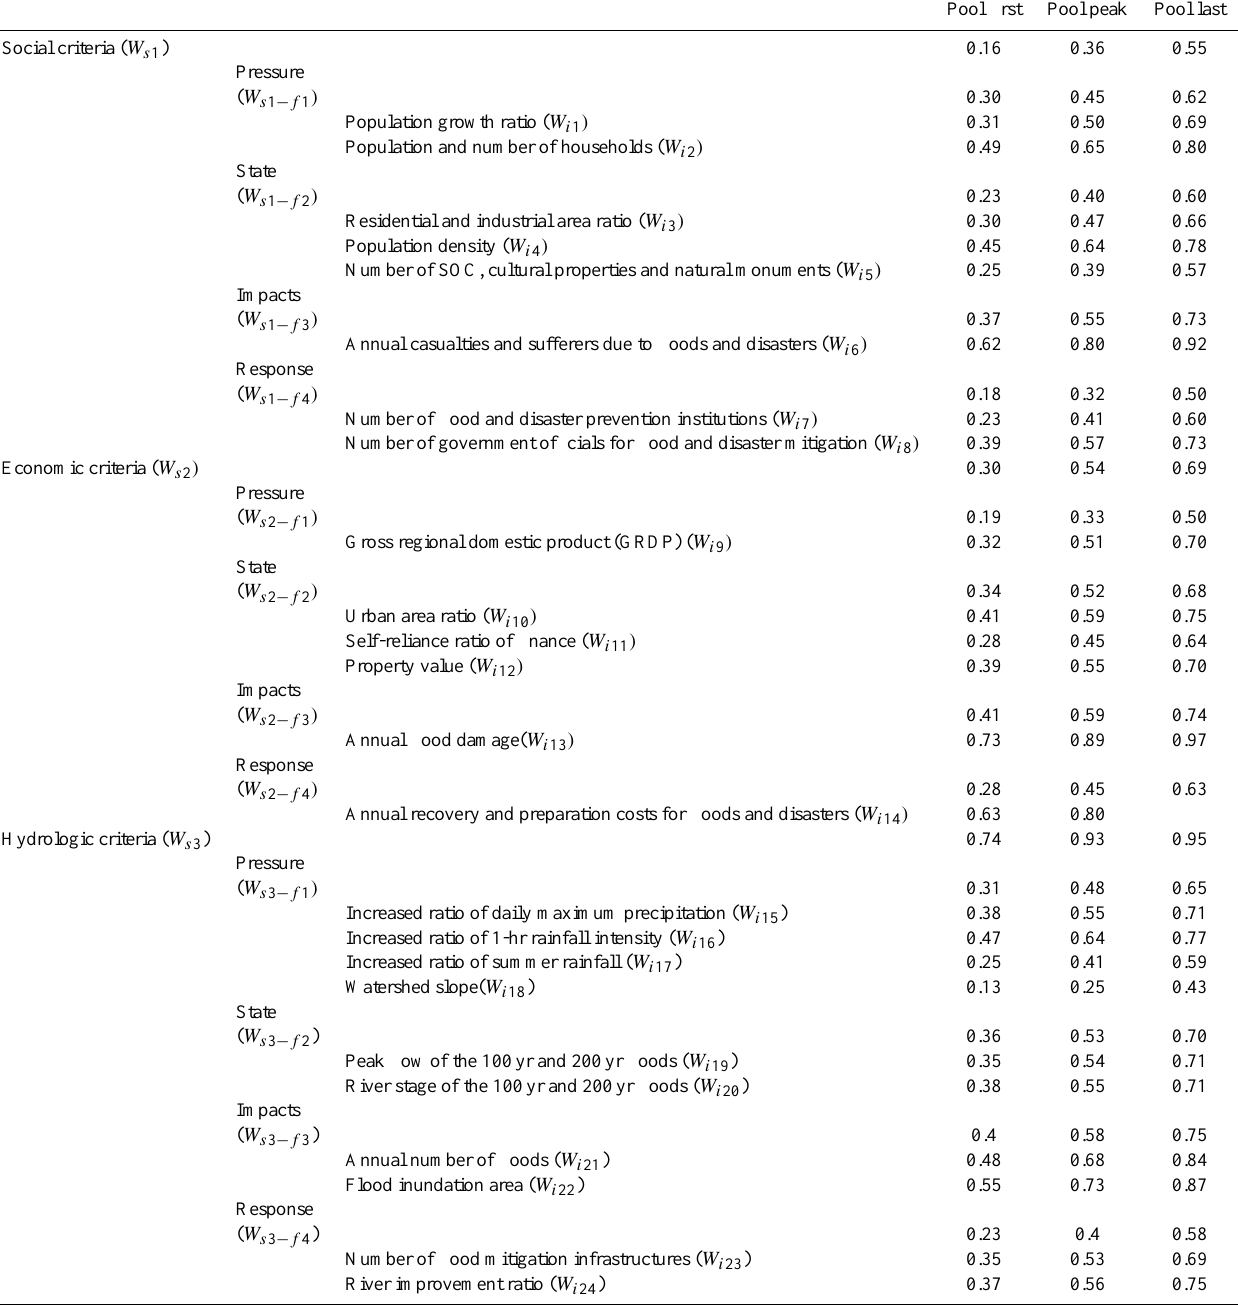
Pool first Pool peak Pool last